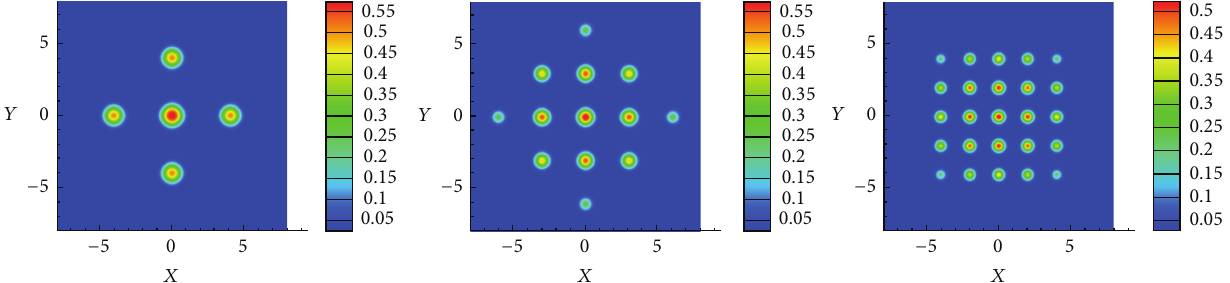
Figure 2: The ground state with fixed 𝛽 = 100 and 𝑑 = 4 , 3 and 𝑑 = 2 from left to right in Example 2.